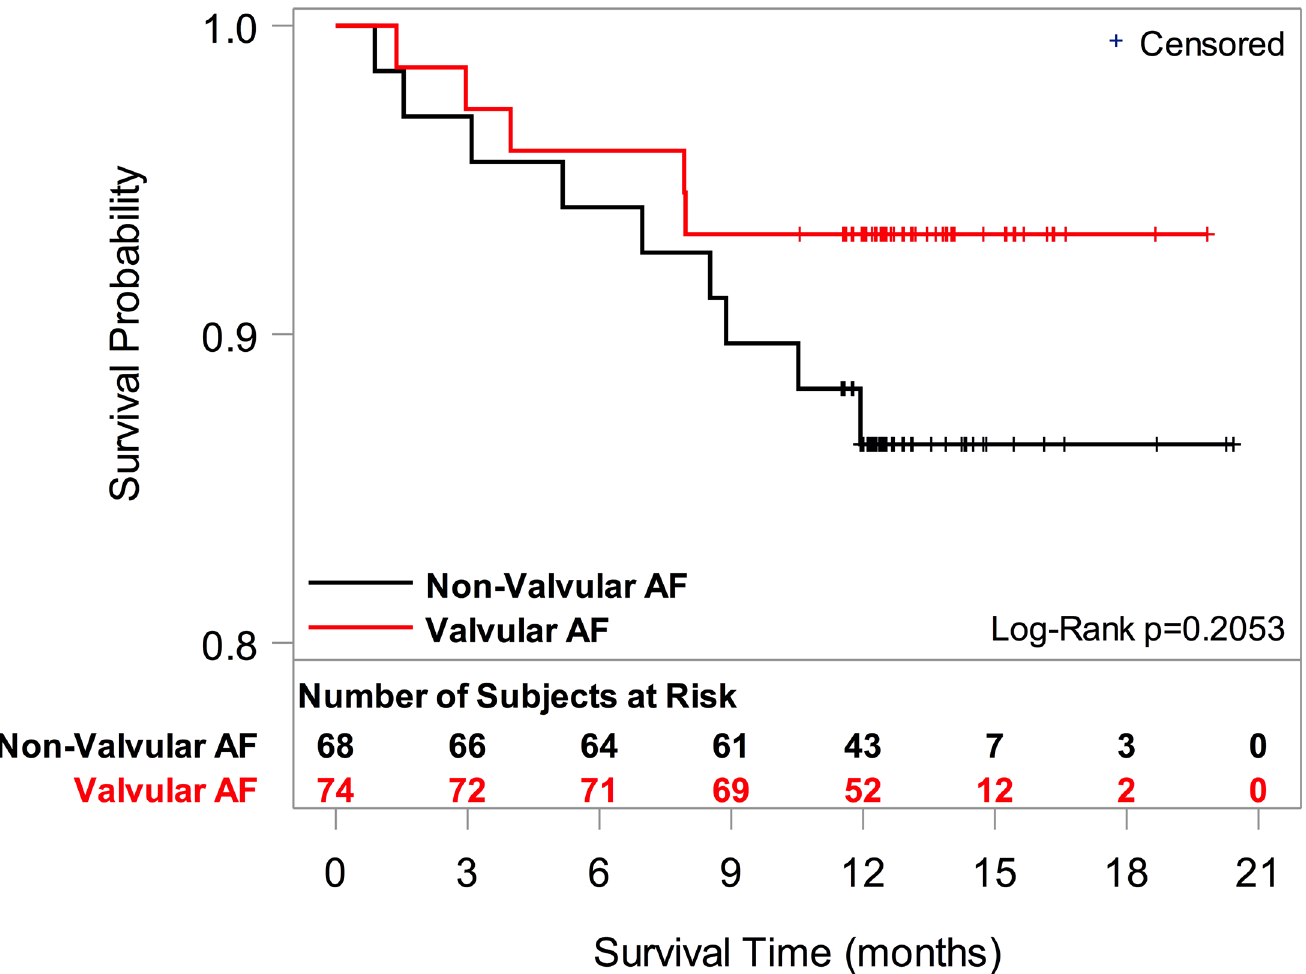
Fig 2. Kaplan-meier survival curve for atrial fibrillation patients. Legend. AF = atrial fibrillation.